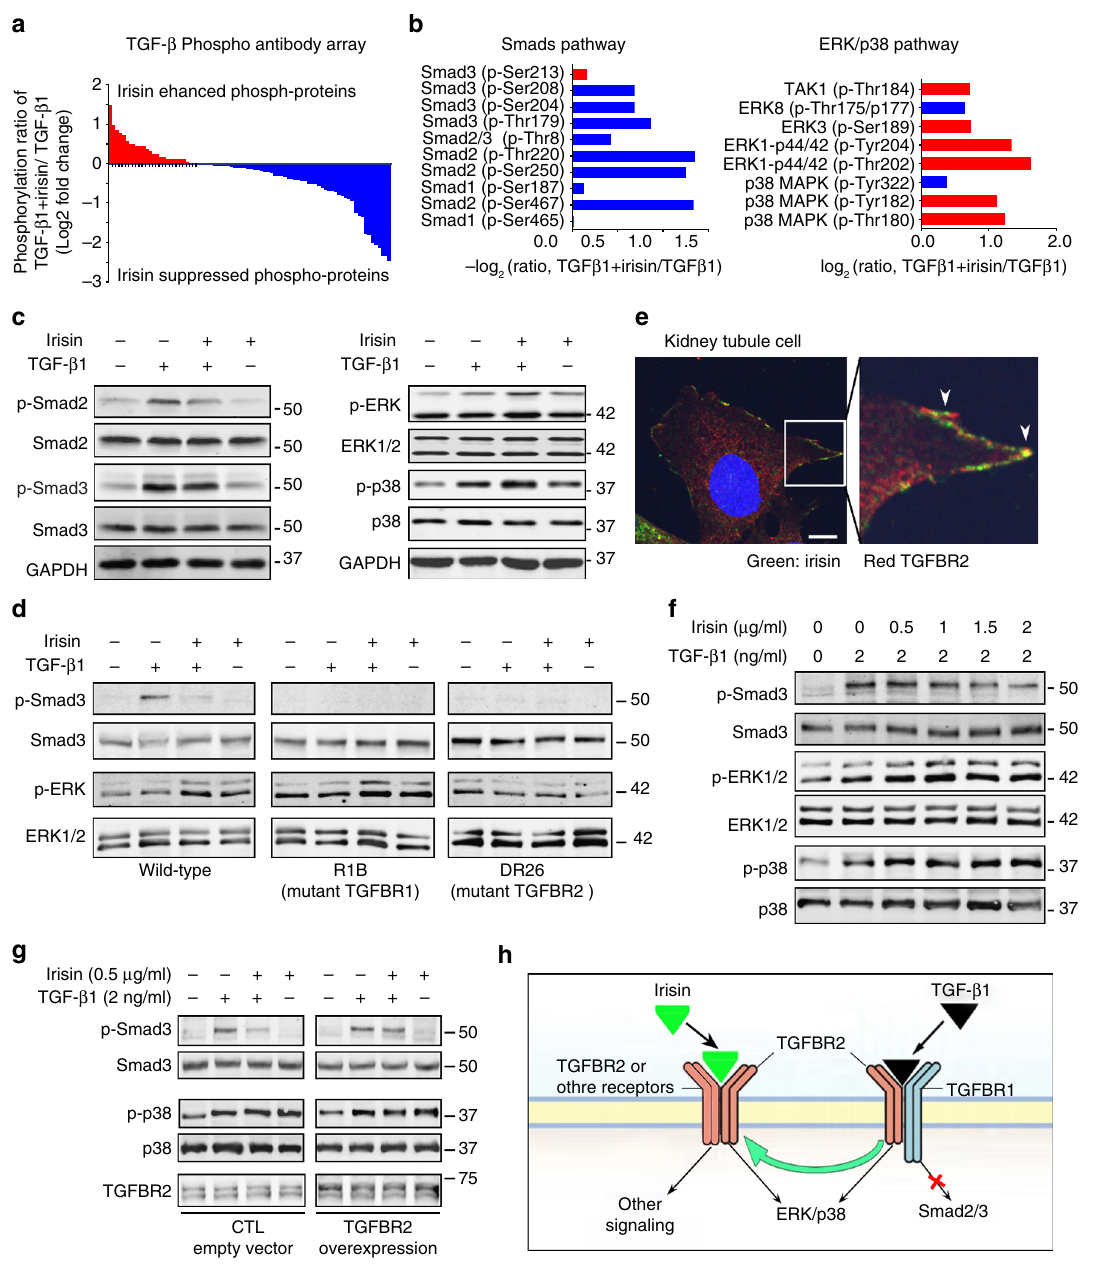
Fig. 6 Irisin antagonizes TGF- β 1 via interfering TGFBR 1 activation in primary tubule cell cultures. a TGF- β 1 Signaling Phosphoproteome array in tubule cells (TGF- β 1 vs. TGF- β 1 plus irisin). Data showing the fold change of enhanced phosphoproteins (red) and suppressed phosphoproteins (blue). b Irisin enhanced ERK/p38 signaling but suppressed Smads signaling upon TGF- β 1 stimulation. c Representative western blots (from three independent experiments) con fi rmed that irisin suppressed Smad2/3 phosphorylation (left panel) while stimulated ERK and p38 phosphorylation. d Representative western blots revealing irisin-induced ERK1/2 phosphorylation was eliminated in DR 26 (TGFBR2 mutant) but not in R1B cell (TGFBR1 mutant). Results were repeated in three independent experiments. e In primary cultured tubule cell, fl uorescein labeled irisin (green) bound to cell membrane that was co- localized with TGFBR2 (red). f Representative western blot showing irisin dose-dependently suppressing TGF- β 1-induced Smad2/3 phosphorylation. Results were repeated in 3 independent experiments. g In tubule cells, overexpression of TGFBR2 blunted the inhibitory effect of irisin on Smad2/3 phosphorylation (representative western blot from three independent experiments). h A possible working model exhibiting how irisin compete TGF- β 1 binding with TGFBR2 β signaling (Fig. 6a and Supplementary Table 1). In this pre- Irisin inhibits the activation of TGF- β type 1 receptor . To ascertain the mechanism by which irisin might counteract TGF- liminarily screen, we found that TGF- β 1 increased the phos- β 1-induced metabolic reprograming in damaged kidney tubule phorylation of Smad2/3; this increase was blunted by irisin cells, we preincubated tubule cells with irisin for 1 h and then (Fig. 6b left panel). Interestingly, TGF- β 1-induced phosphoryla- added TGF- β 1 for 2 h. Using a TGF- β -phospho-antibody array, tion of ERK and p38 can be enhanced by irisin (Fig. 6b, right we examined 86 phosphorylated proteins that are related to TGF- panel). Using western blotting, we con fi rmed that irisin NATURE COMMUNICATIONS | 8: